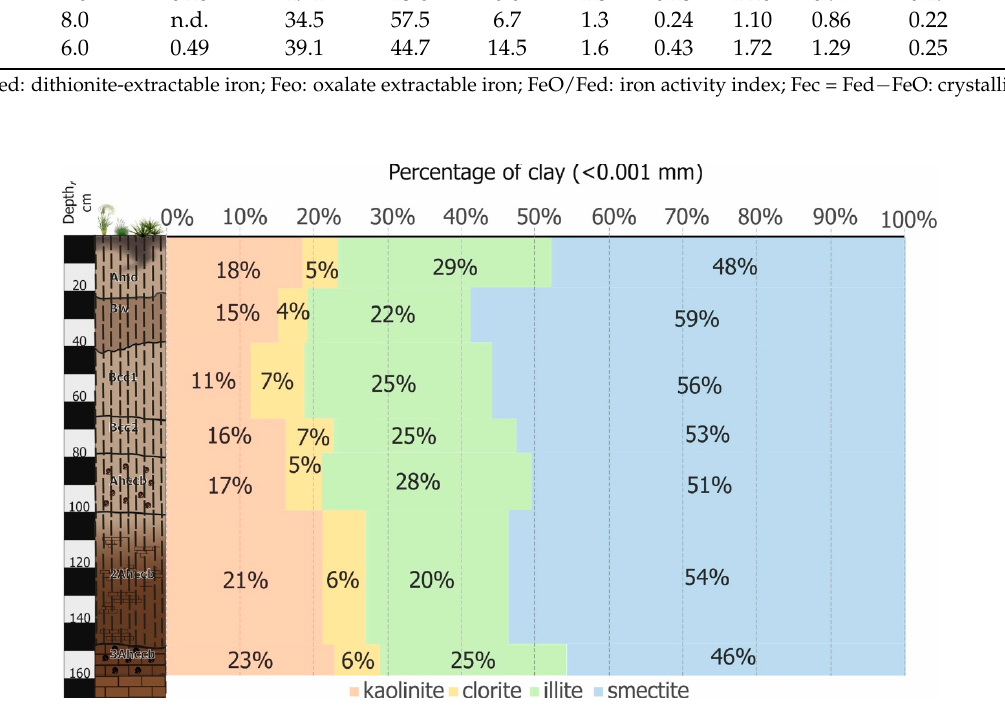
Figure 11. Clay minerals, percentage of total clay contents in Surface Kastanozem, Srednaya Akhtuba section.